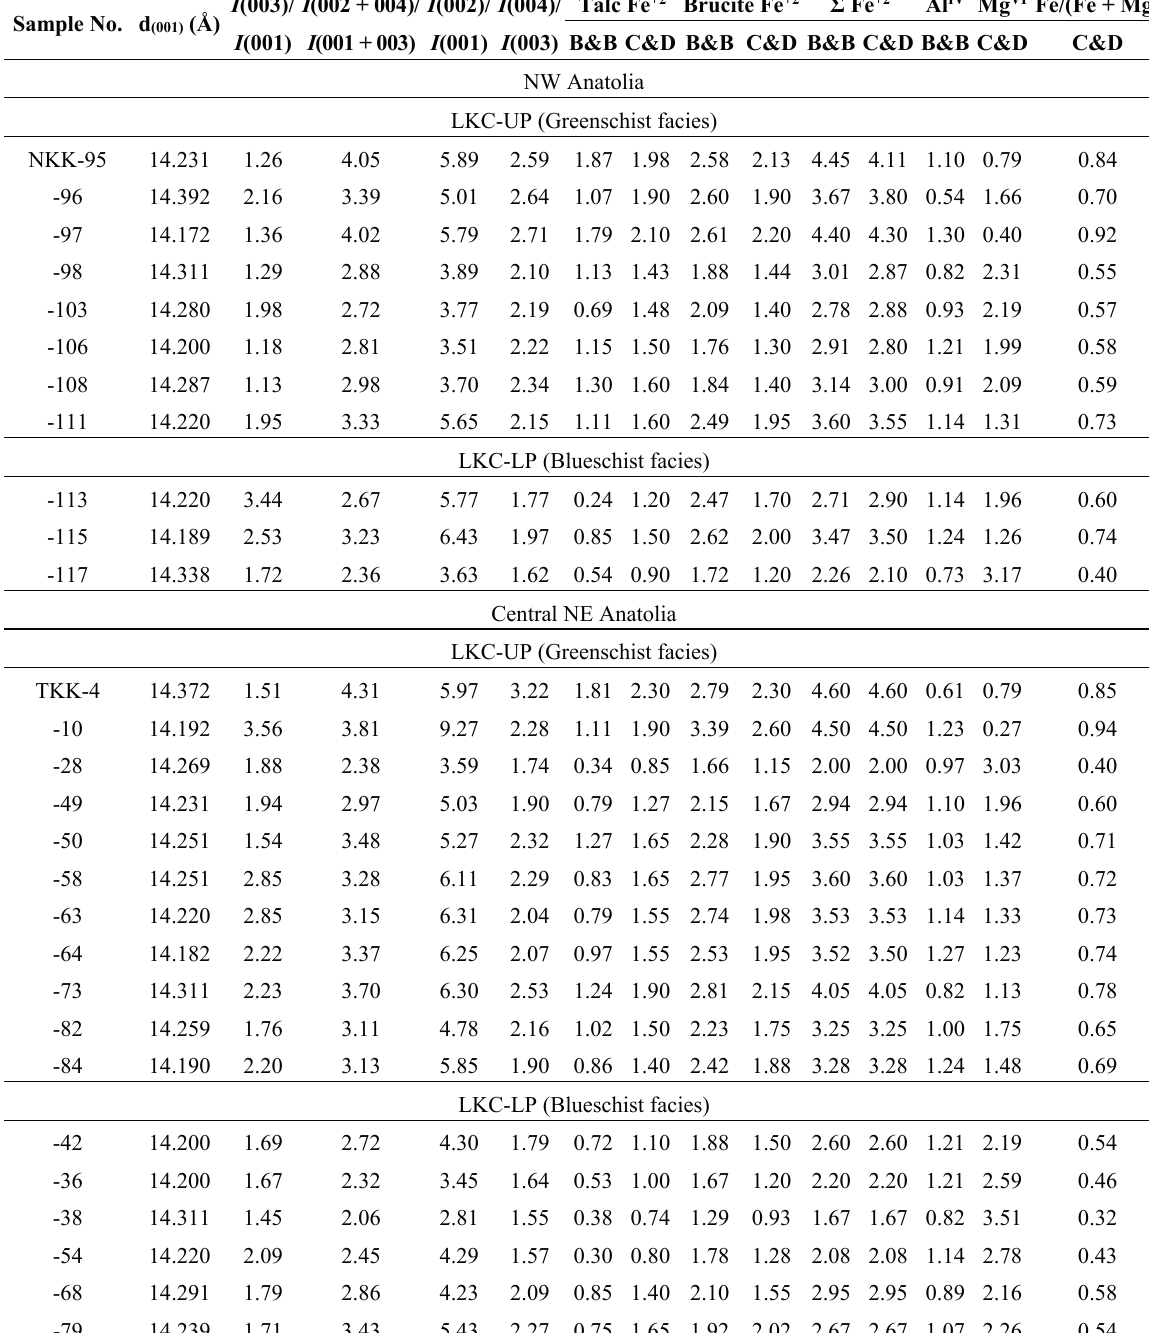
Table 3. X-ray diffraction (XRD) basal reflections and chemical compositions of chlorite minerals in the Lower Karakaya Complex units. B: Brindley [42], B&B: Brindley and Brown [43], C&D: Chagnon and Desjardins [44]), Al IV = Al VI and Mg = 6 − (Fe + Al IV